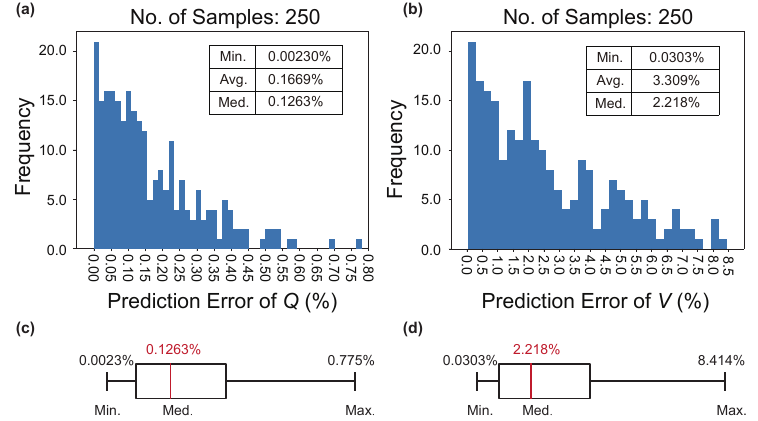
Figure 9. Validation results of the trained LRS-RCNN for L3 nanocavity using the validation dataset. Plotted is the histogram of (cid:101) pred for Q in ( a ) and V in ( b ). The boxplot in ( c ) is extracted from data in ( a ), and ( d ) from ( b ). Inset data: minimum, average, and median (cid:101) pred values in the histograms.